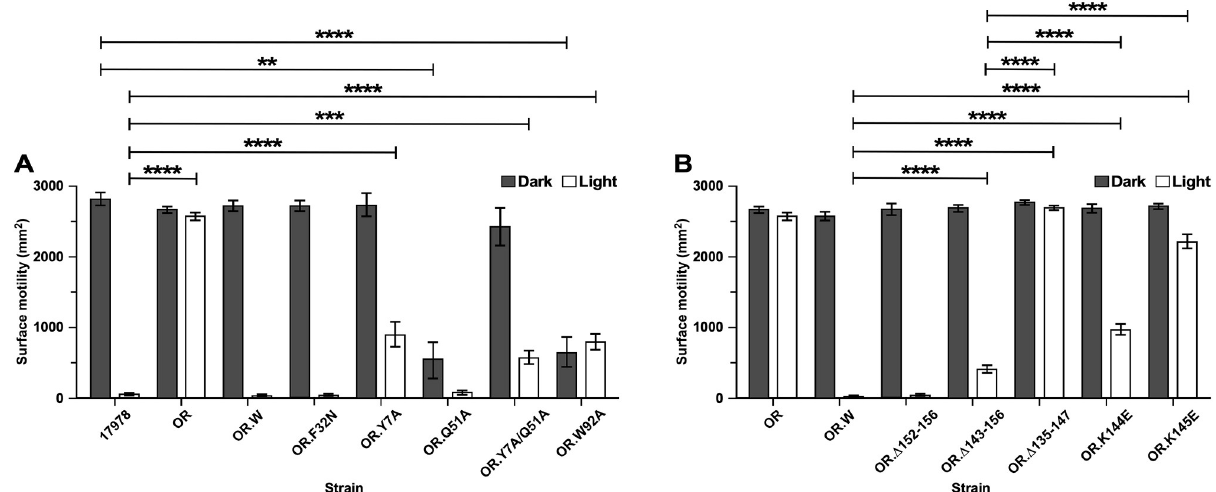
Fig 3. Light-regulated surface motility of 17978 cells producing native BlsA or derivatives generated by site-directed mutagenesis. (A) Motility of OR BlsA-deficient cells transformed with a pMU368 derivative coding for the F32N (OR.F32N), Y7A (OR.Y7A), Q51A (OR.Q51A), Y7A/Q51A (OR. Y7A/Q51A) or W92A (OR.W92A) NT mutant proteins. (B) Motility of OR BlsA deficient cells transformed with a pMU368 derivative coding for the Δ 152–156 (OR. Δ 152–156), Δ 143–156 (OR. Δ 143–156), Δ 135–147 (OR. Δ 135–147), K144E (OR.K144E) or K145E (OR.K145E) CT mutant proteins. The motility responses of the 17978 parental strain (17978), the BlsA OR mutant (OR) and the OR mutant transformed with a pMU368 derivative coding for the wild type protein (OR.W) were used as controls. Surface motility was tested using SA plates incubated at 24˚C under darkness or illumination. Horizontal bars identify statistically different values ( P � 0.01, �� ; P � 0.001, ��� ; P � 0.0001, ���� ) and error bars represent the standard error of each data set.